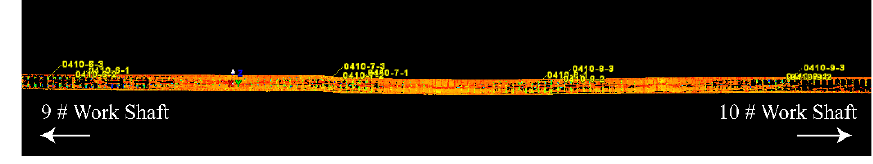
Figure 7. 3D point cloud alignment results of the provided case.